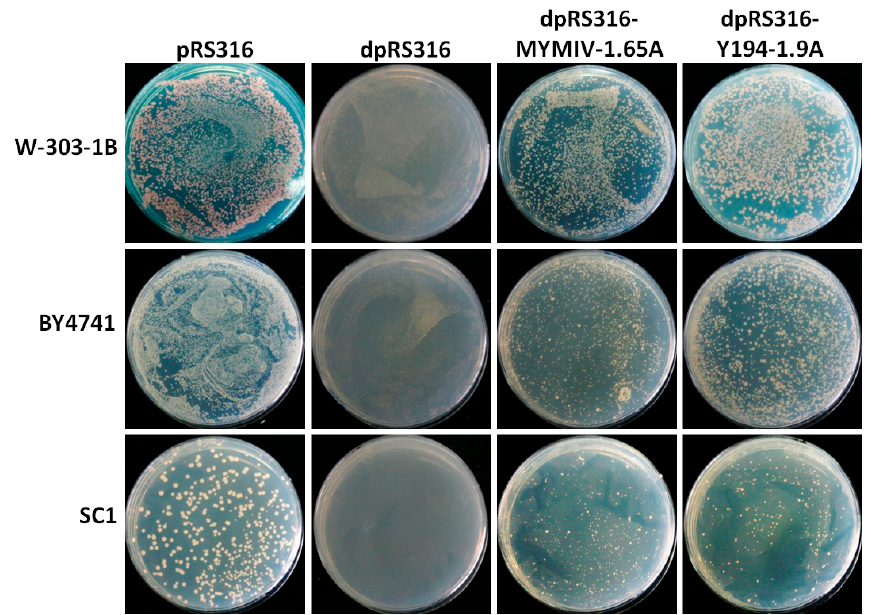
Figure 2. The recombinant plasmid with MYMIV or Y194 DNA could replicate in three types of yeast strains (W303-1B, BY4741 and SC1). The indicated yeast cells (W303-1B, BY4741 or SC1) were transformed with pRS316, dpRS316, dpRS316-MYMIV-1.65A, or dpRS316-Y194-1.9A, individually. Photographs were taken at 5 d after transformation.